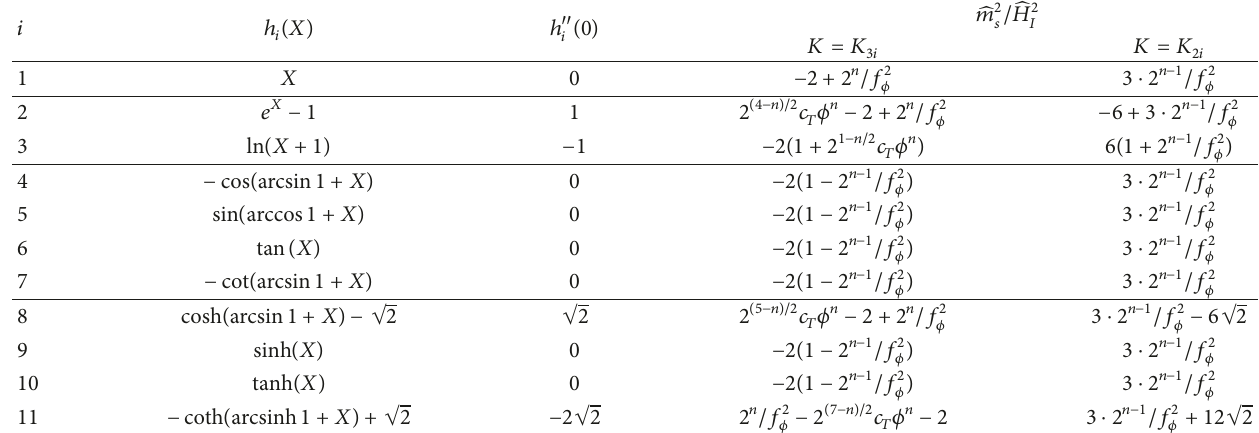
Table 1: Definition of the various ℎ 𝑖 (𝑋) ’s, ℎ 󸀠󸀠 𝑖 (0) = 𝑑 2 ℎ 𝑖 (0)/𝑑𝑋 2 and masses squared of the fluctuations of 𝑠 and 𝑠 along the inflationary trajectory in (46) for 𝐾 = 𝐾 3𝑖 and 𝐾 2𝑖